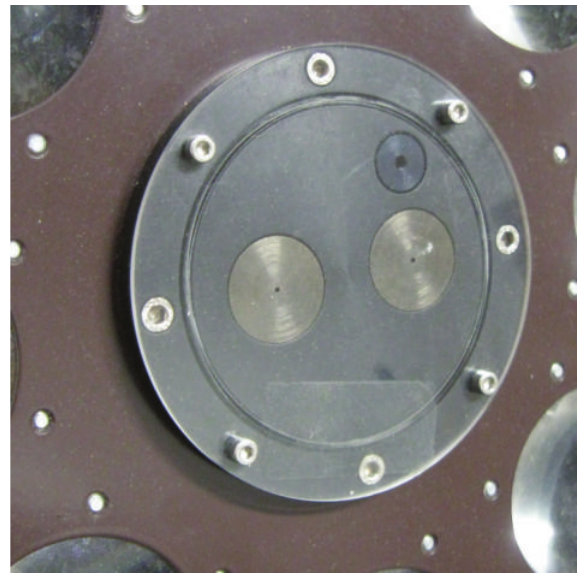
Figure 18: The sun finder with 2 sections mounted with the cover- ing